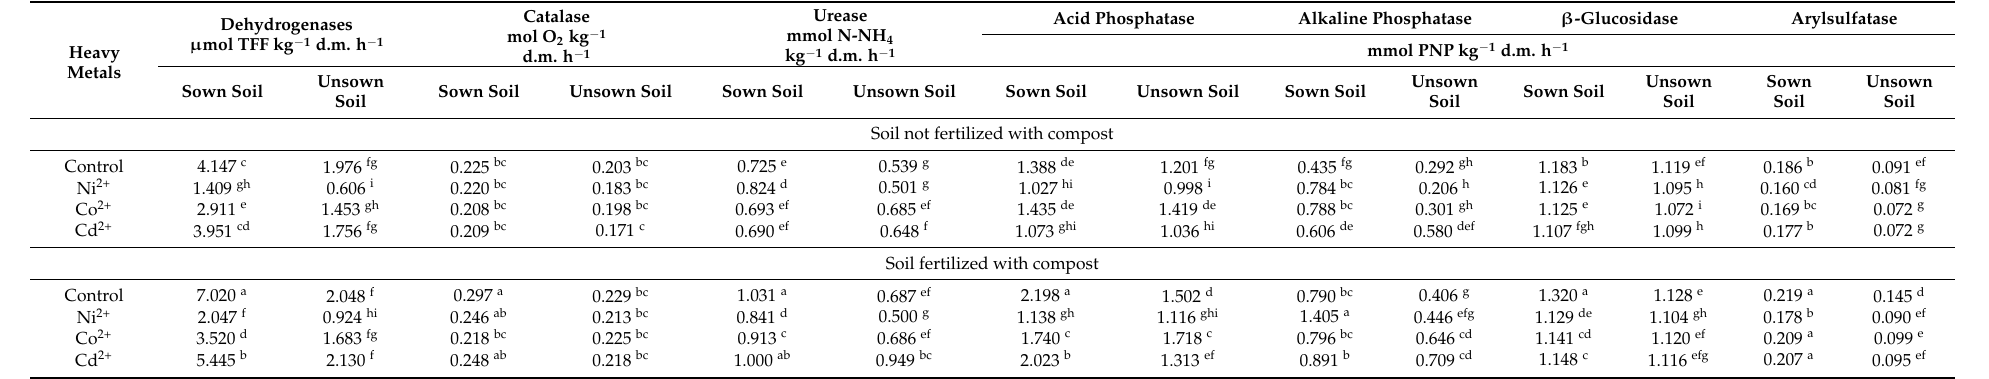
Table 5. Enzyme activity in soil contaminated with heavy